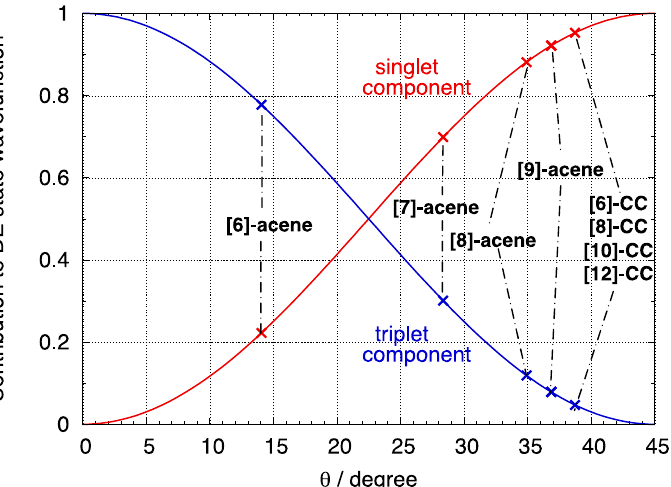
Figure 7. Contributions of the singlet and triplet components to the DE state described at TDUDFT level according to Equation (6) as a function of BS orbital rotation angle 𝜃 . The investigated linear and cyclic acenes are placed on the graph with crosses based on their computed BS orbital rotation angle 𝜃.